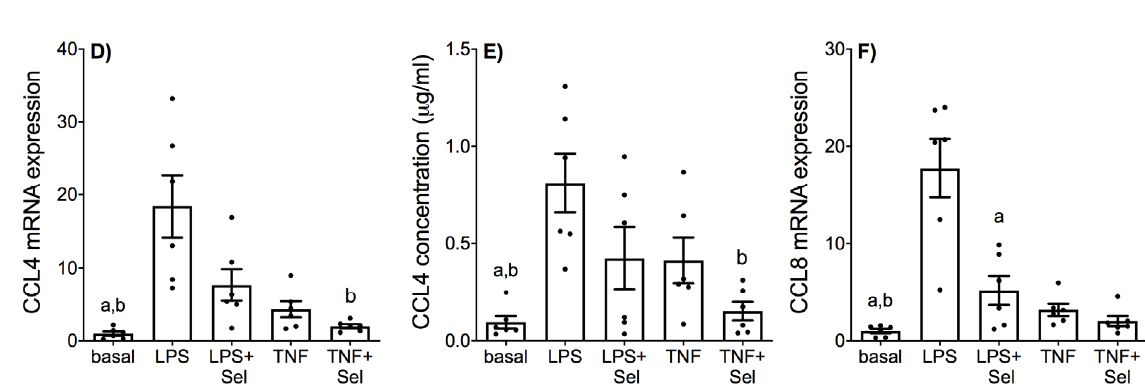
Figure 6. Effect of selenium on CCL chemokine expression in VAT from pregnant women. VAT was incubated with or without 10 µM sodium selenite (Sel) for 1 h and then stimulated with 10 µg/mL LPS or 10 ng/mL TNF- α for a further 20 h ( n = 6 patients). ( A , C , D , F ) CCL2, CCL3, CCL4 and CCL8 mRNA expression was analysed by RT-qPCR and fold change was calculated relative to basal expression. ( B , E ) The concentration of CCL2 and CCL4 in the conditioned media was assayed by ELISA. For all graphs, individual data points represent six independent experiments and are displayed as mean ± SEM. a p ≤ 0.05 vs. LPS, b p ≤ 0.05 vs. TNF; repeated measures one-way ANOVA.